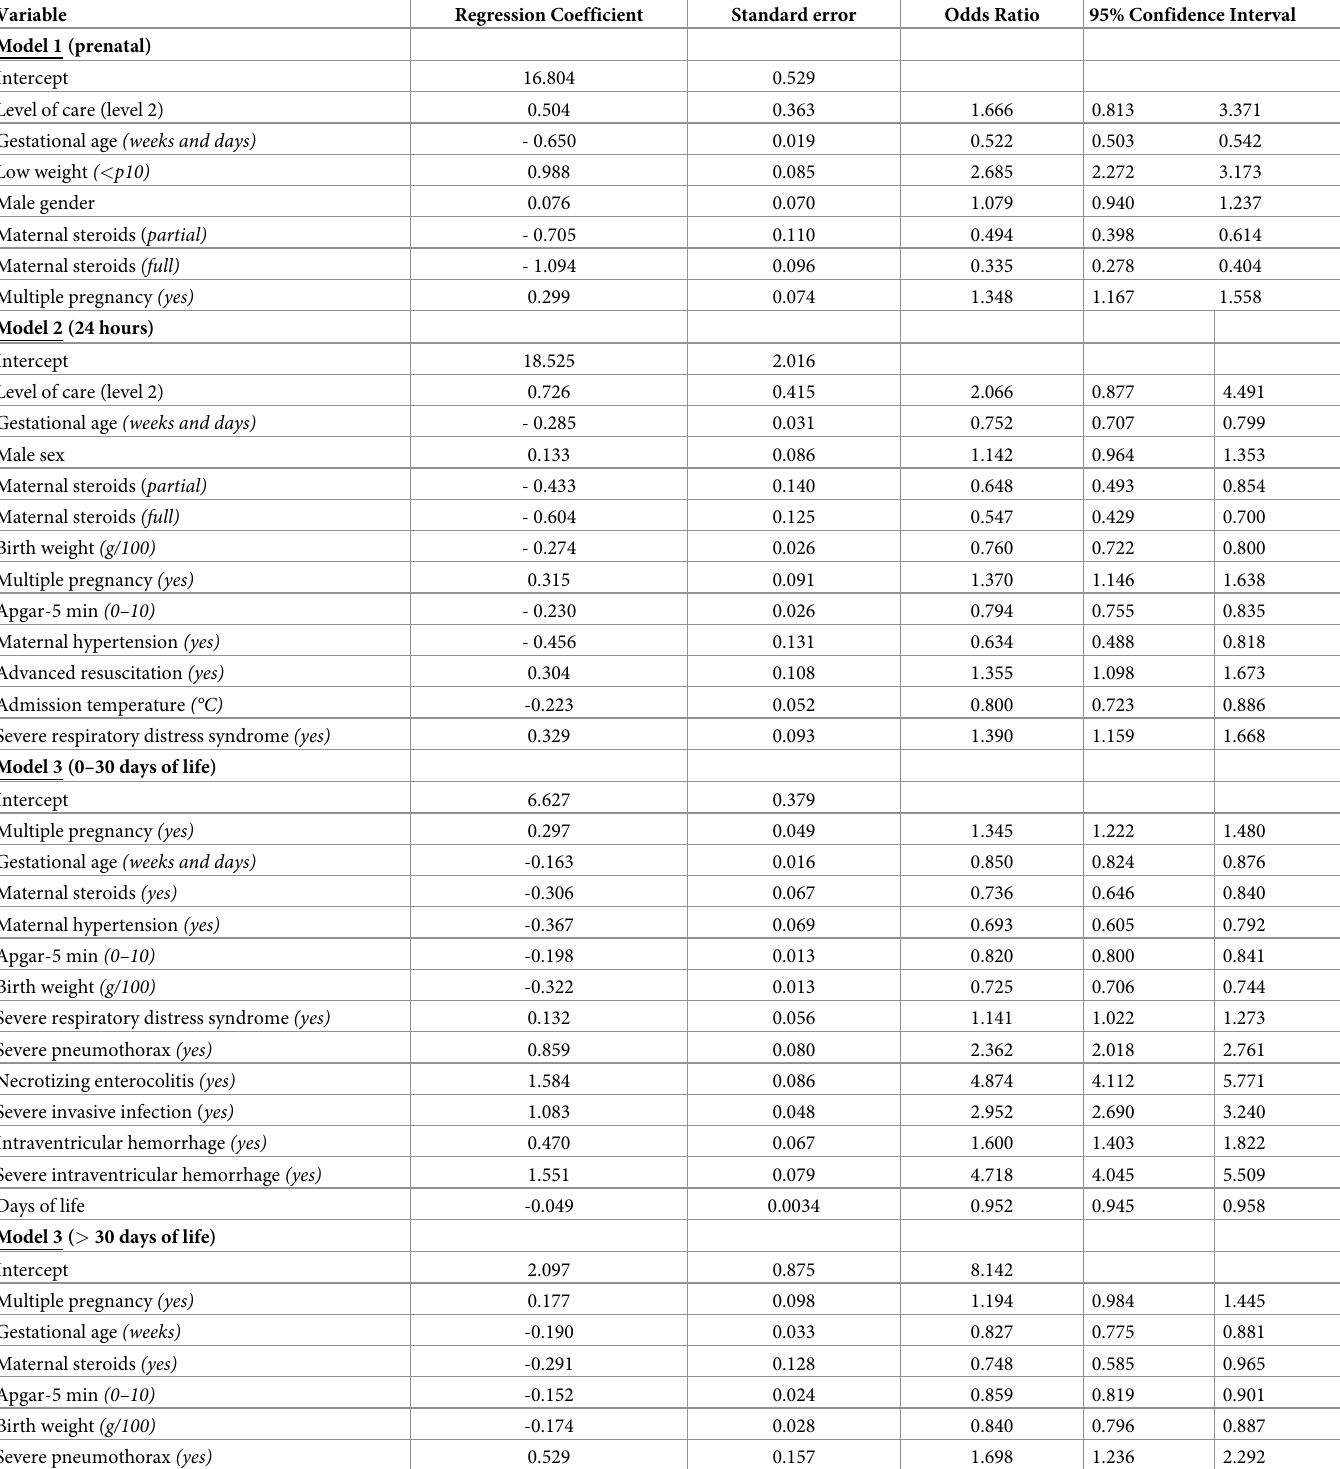
Table 3. Regression coefficients, standard errors, odds ratios, and 95% confidence intervals for the multiple logistic regression equations developed for each model. The main outcome is mortality before